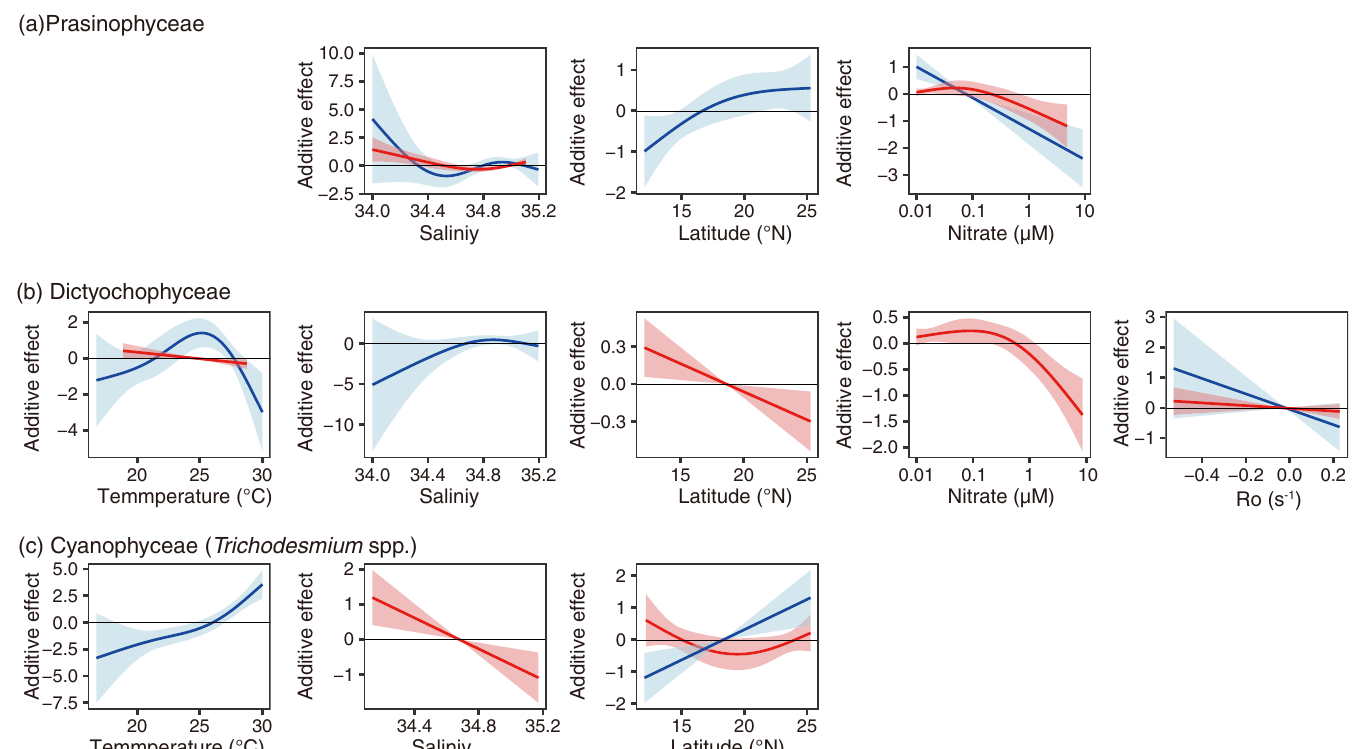
Fig 7. Partial effects of delta GAMs on (a) Prasinophyceae, (b) Dictyochophyceae, and (c) Cyanophyceae ( Trichodesmium spp.). The blue line with blue shadow indicates the result of the present–absent GAM, and that of the red the result of the abundance GAM. The shadows denote the 95% confidential intervals.